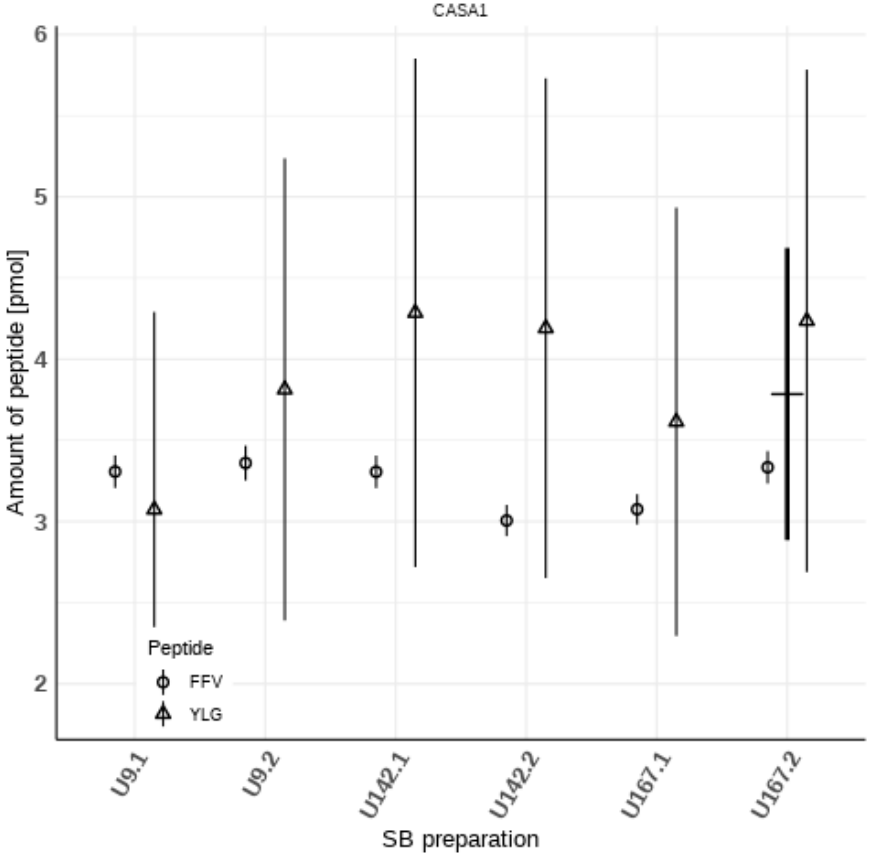
Figure 1. Measured amounts of peptides FFV (i = 1) and YLG (i = 2) of protein CASA1 (j = 1) in the six SBs (index k = 1 to 6, left to right); symbols depict the quantity values of the respective peptides, and the vertical bars the associated expanded uncertainties (expansion factor k = 2); as an example, the horizontal and bold vertical bar for SB U167.2 depict the mean of the two quantity values and the absolute expanded uncertainty of f P-P, 1 , 6 (Table 2), respectively.